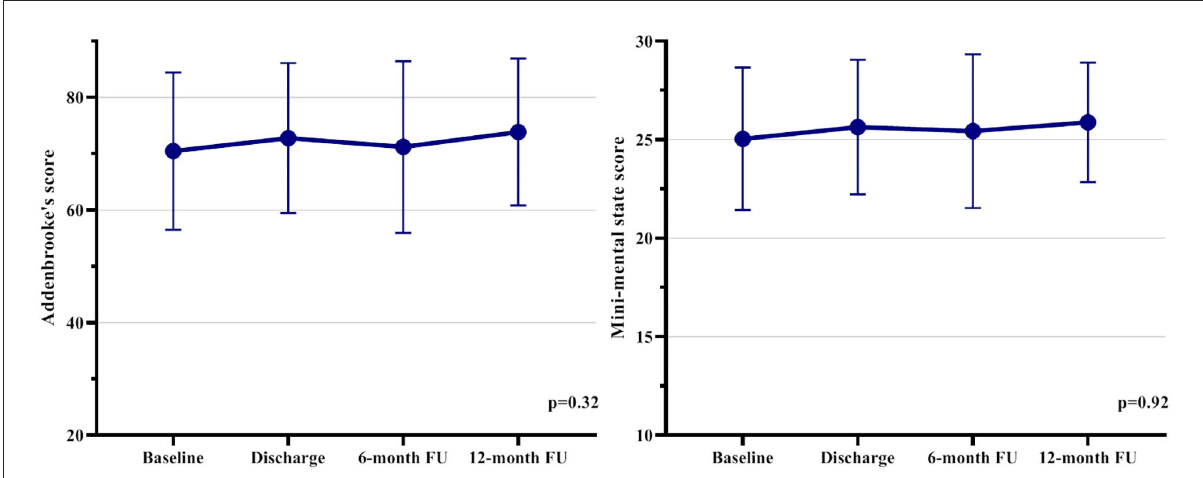
FIGURE5 Neurocognitive examination results in the 79 patients based on serial assessments. The overall neurocognitive function was stable during the one-year follow-up.